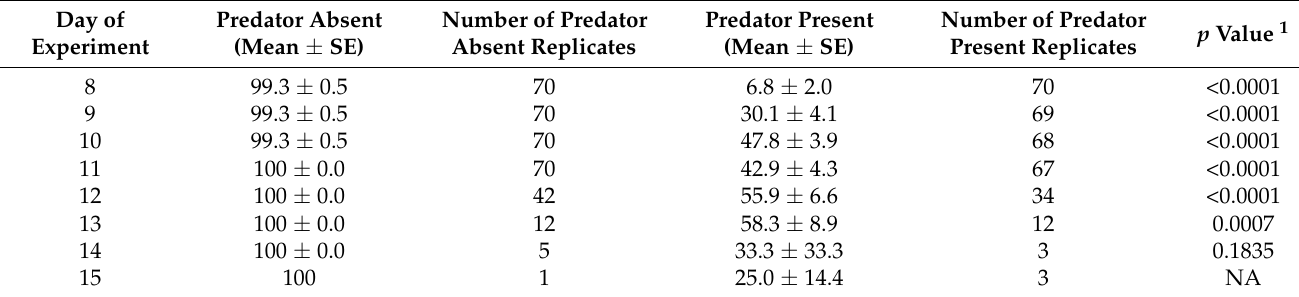
Table 1. Early instar survival percentage by day and predator presence.